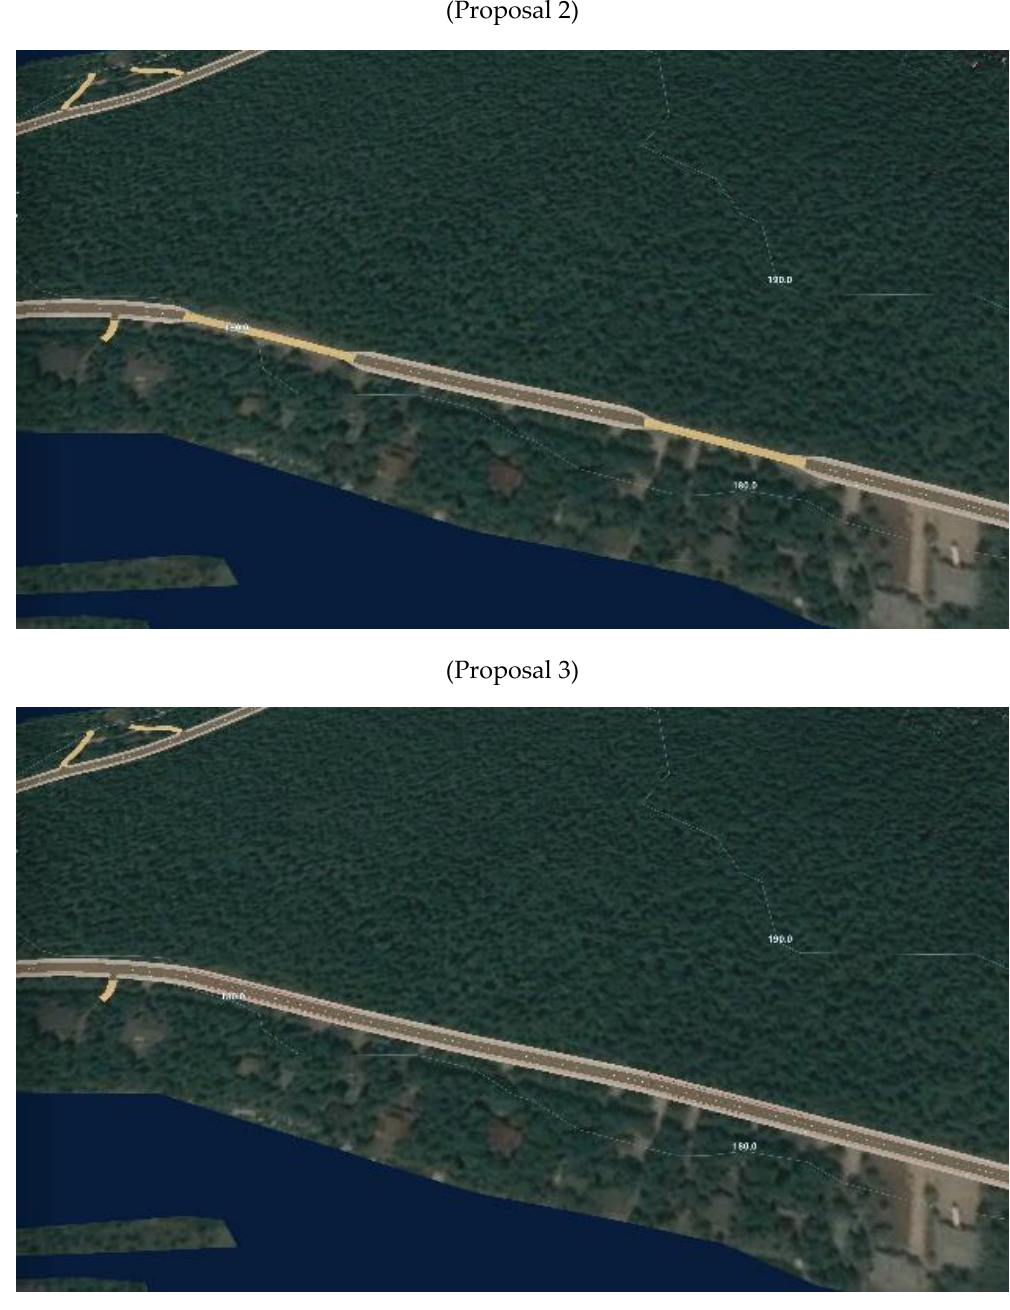
Figure 14. Problems with misclassified roads: the software was able to handle the transition between different road typologies, resulting in an unrealistic model for the road.